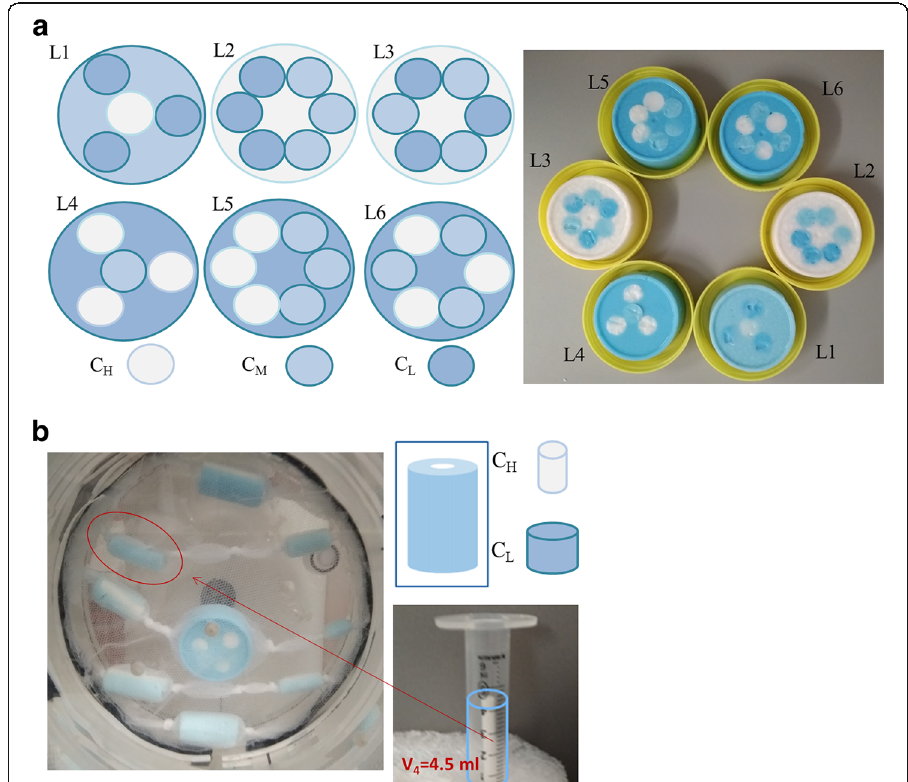
Fig. 3 Experimental heterogeneous simulated lesions with cylindrical areas of different activity concentrations developed for the evaluation of the segmentation accuracy and the radiomic feature reliability given by automatic PET segmentation approaches. a Eighteen simulated lesions with a diameter longer than 3× FWHM. b Eight cylindrical lesions (V1 to V8) with 2 concentration layers (external cylinder with CL and inner cylinder with CH, CH/CL =